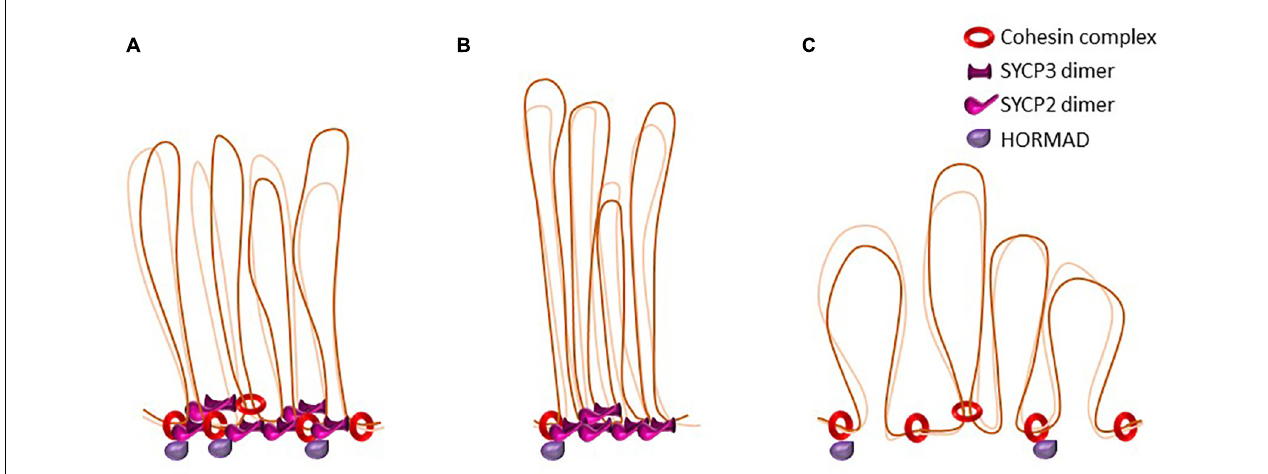
FIGURE 3 | The dynamics of loop-axis organization. Schematic representation of axial elements in the mouse. Cohesins form the axial core onto which other axial element proteins such HORMADs, SYCP2, and SYCP3 bind. Some cohesin complexes are involved in sister cohesion, others might be involved in the formation of the loop axis-structure. SYCP3 and SYCP2 form an antiparallel heterotetramer. (A) representation of wild type axial elements. (B) Representation of loop-axis structure in mouse mutants for the cohesin subunit SMC1 β . Axes are twofold shorter and loops appear longer and less homogenous in size. In this mutant, HORMAD is able to load on axes. (C) Representation of loop-axis structure in mice deficient for SYCP3. Cohesin axis core is formed but axes are almost twofold longer and loops appear shorter, irregular, and denser. SYCP2 is not detected on axes in the absence of